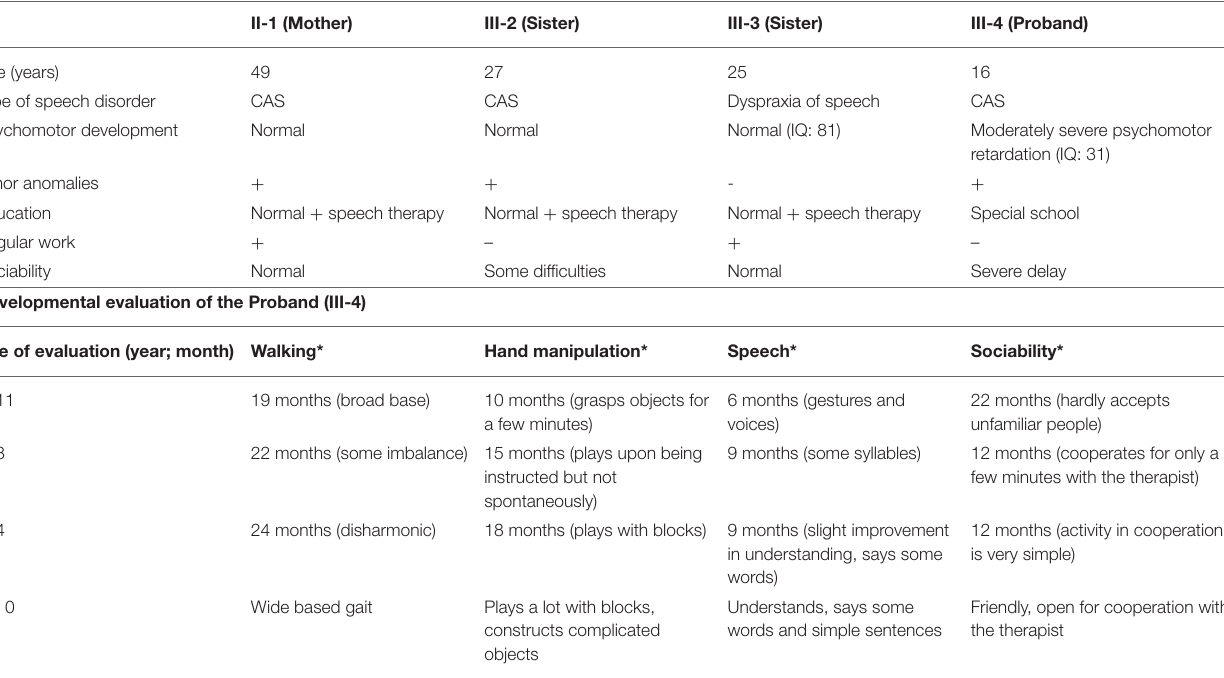
( Figure 2A ). The size of the deletion and the breakpoints were exactly the same in every patient. The extent of